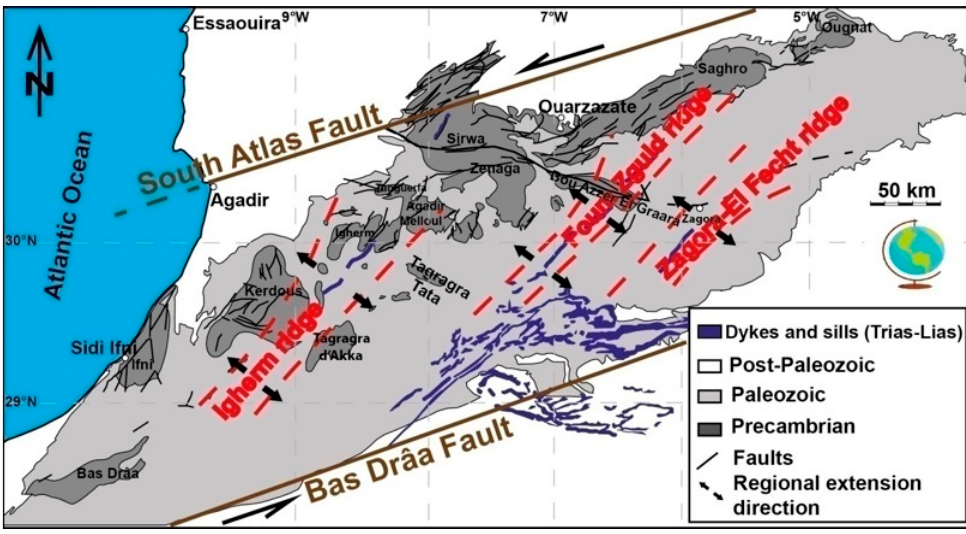
Figure 13. Interpretative structural map of the Anti-Atlas during the Late Triassic–Lower Liassic.